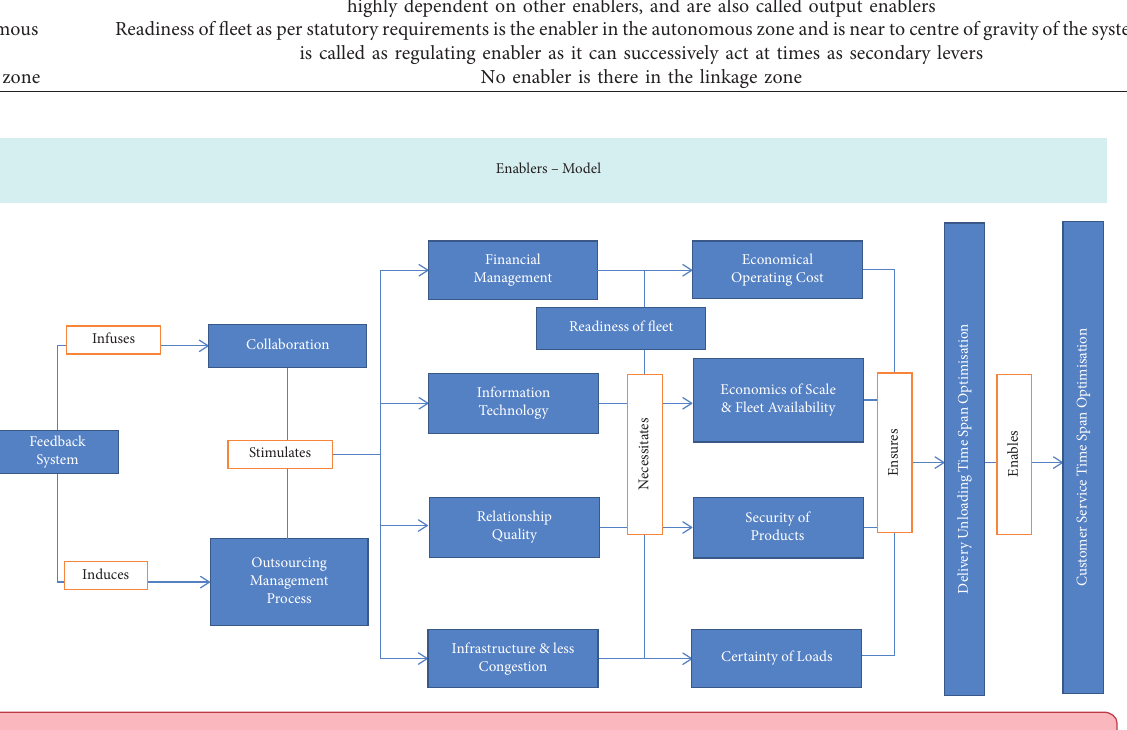
Figure 8: Model for enablers to achieve strategic focus of top